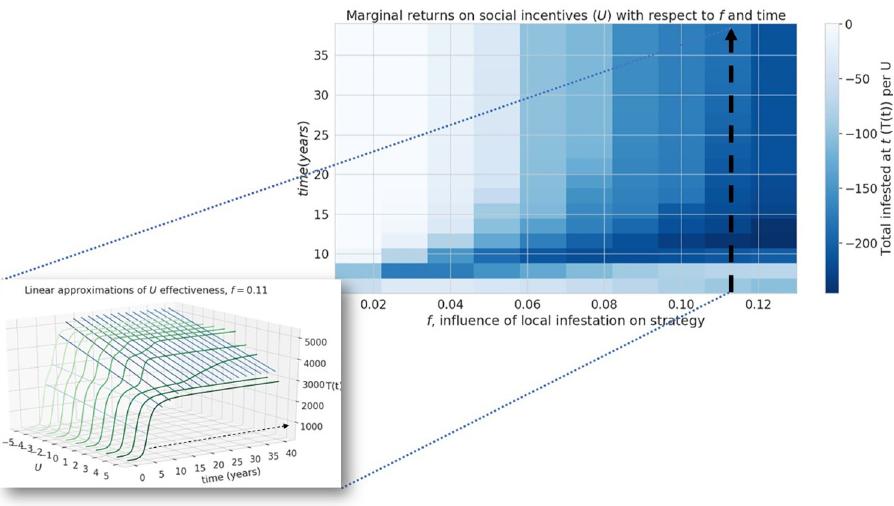
Fig 4. Efficacy of social incentives on infestation after time T . Inset graph shows an example of cross-section along the line f = 0.11 The influence of infestation on transport strategy, f , can hinder the intervention by public outreach, in the long-term (after approximately 20 years). The inset figure illustrates how one column in the heat map, shown by the dotted line, is constructed from the slopes of linear approximations of T ( t ) over U 2 [ − 5, 5]. The blueness of the lines going left to right is a function of their slope, corresponding to the color of the cells in the